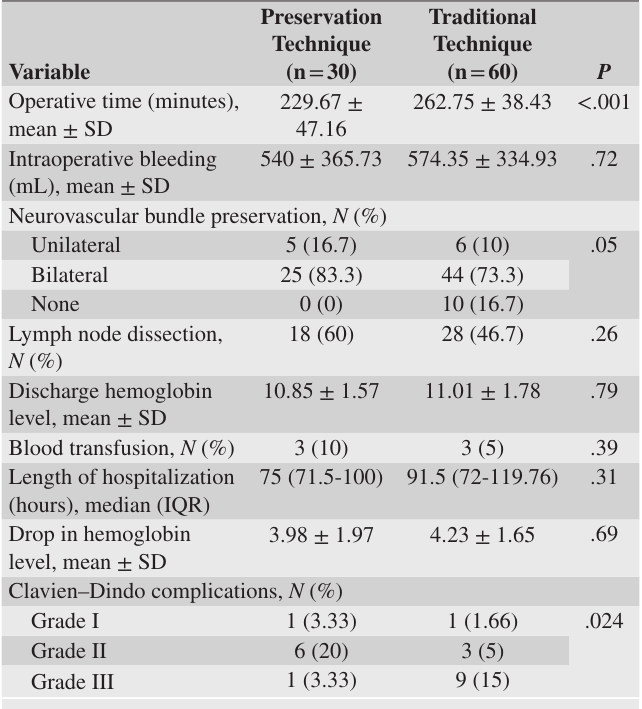
Table 2. Perioperative